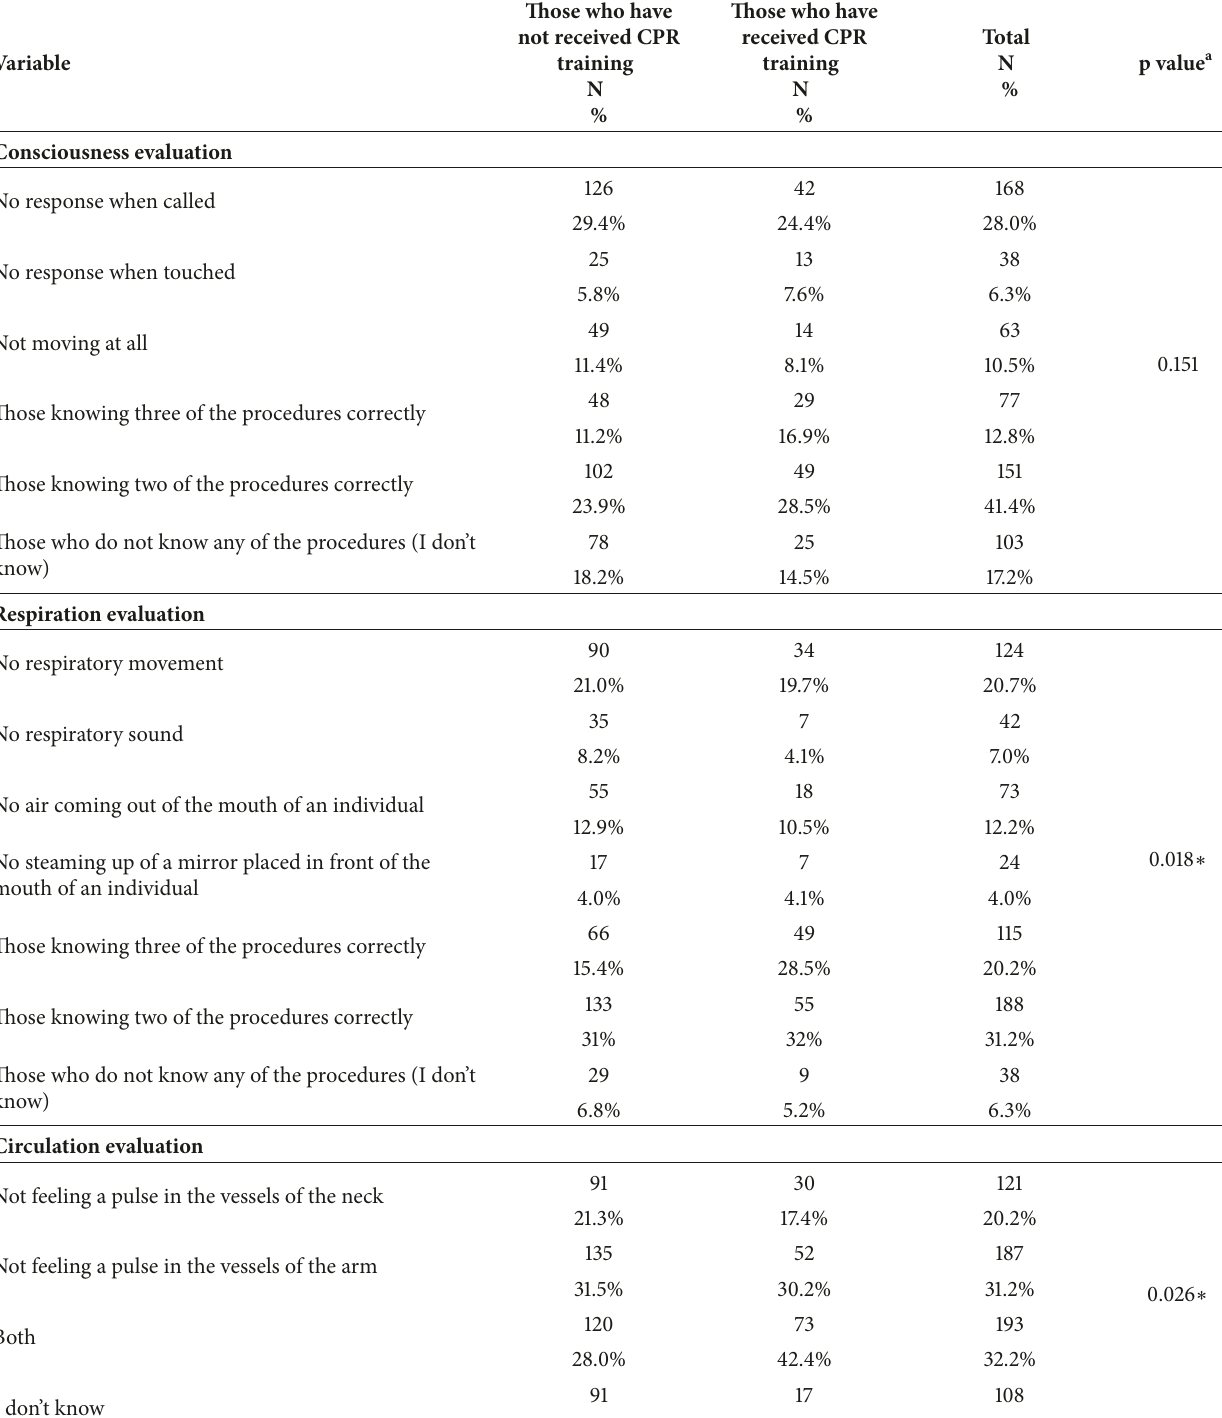
Table 8: Association between identification of cardiac arrest findings and CPR